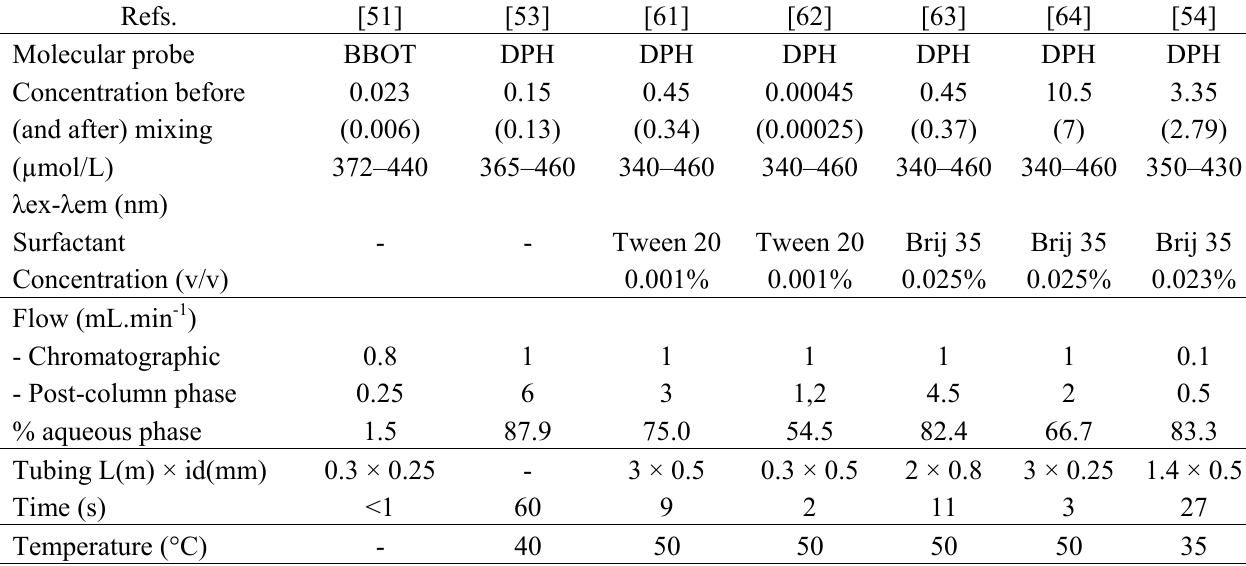
Table 3. Fluorescence post-column derivatizations used in